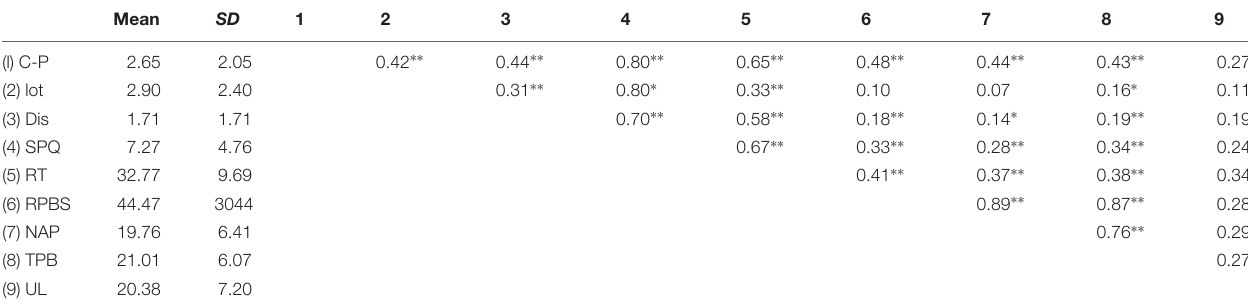
TABLE 1 | Scale descriptive statistics and